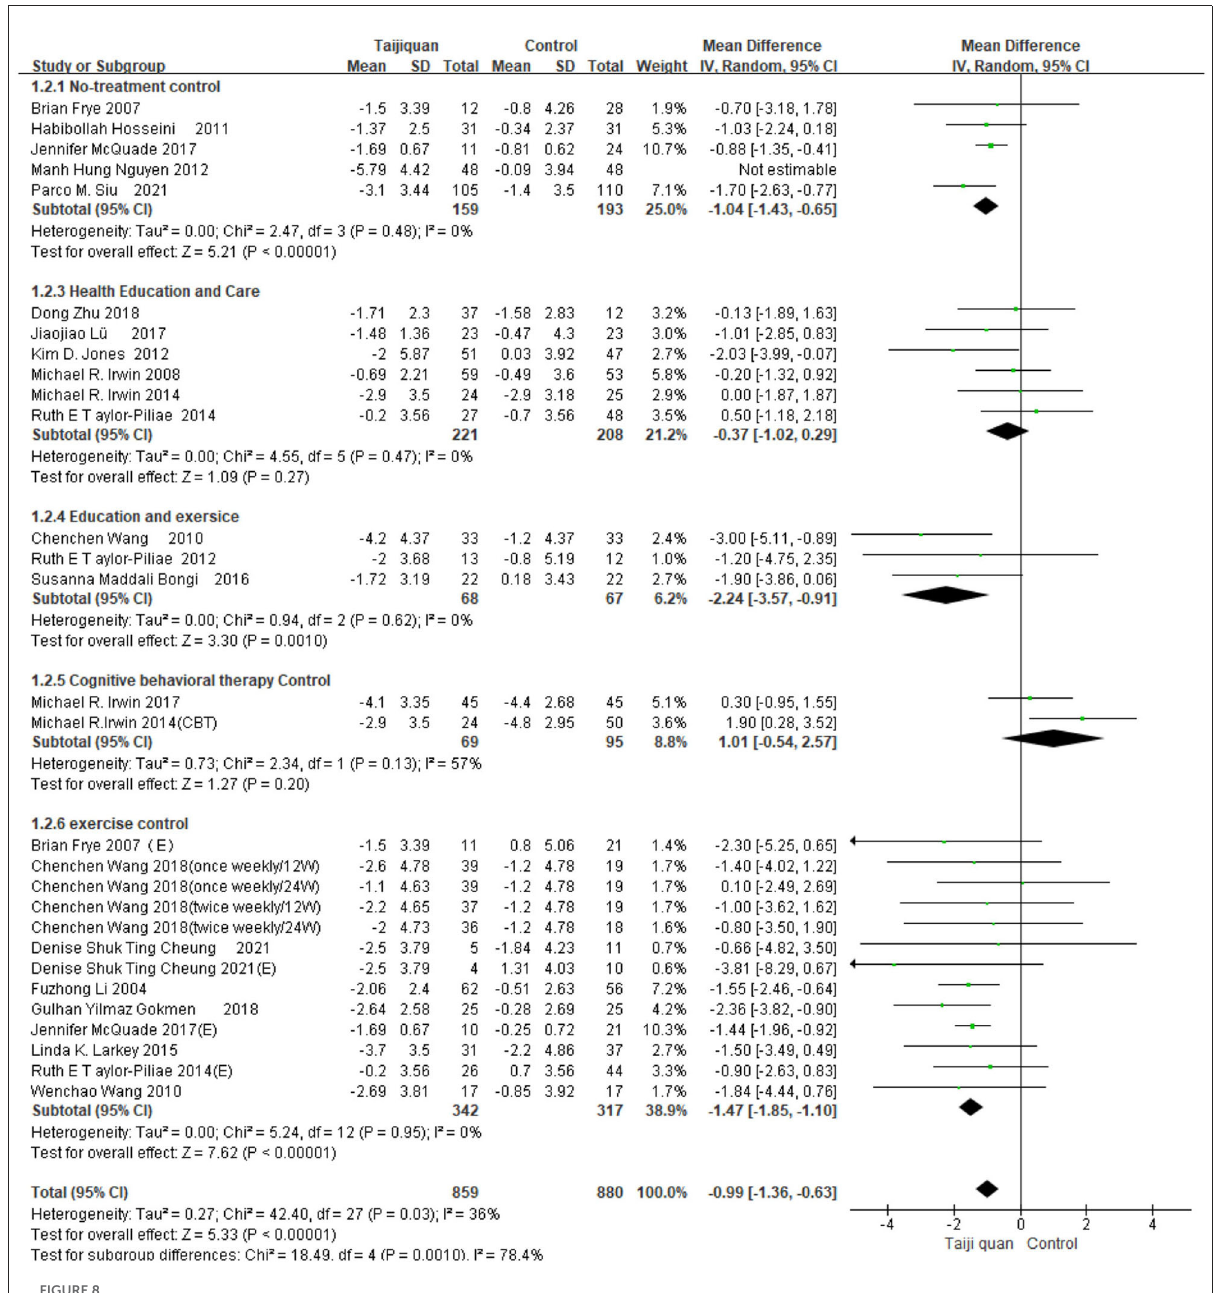
FIGURE8 Subgroups of different control groups analyzed forest